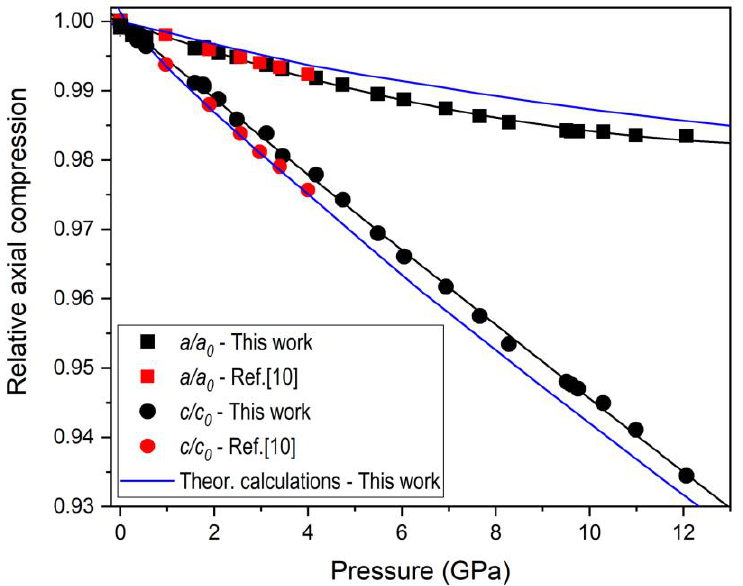
Figure 4. Relative axial compressibilities of the iron-rich ankerite structure. Experimental relative contractions a / a 0 and c / c 0 are represented as solid squares and circles, respectively (black: our data; red: data from [10]). Results from DFT calculations for pure CaFe(CO 3 ) 2 ankerite are depicted as blue lines.